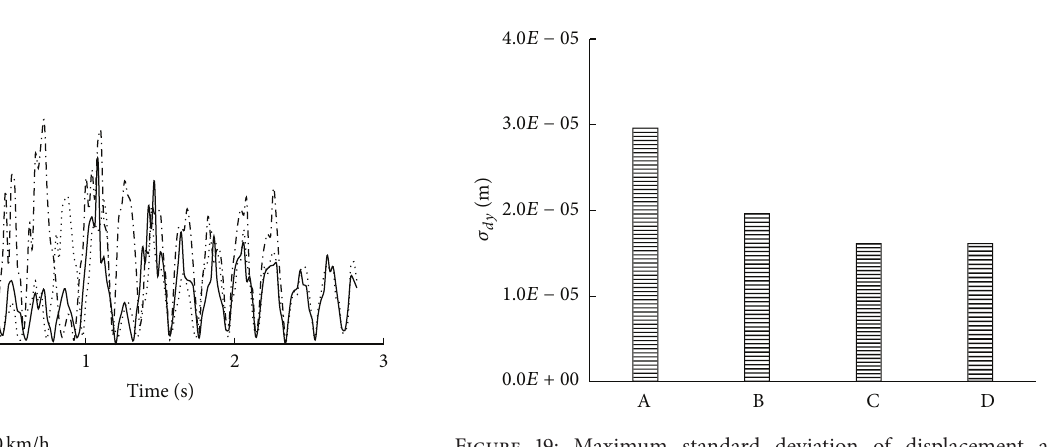
Figure 19: Maximum standard deviation of displacement at midspan, (A) rigid vehicle, (B) flexible vehicle only with first structural mode, (C) flexible vehicle with first three structural modes, and (D) flexible vehicle with first five structural modes.